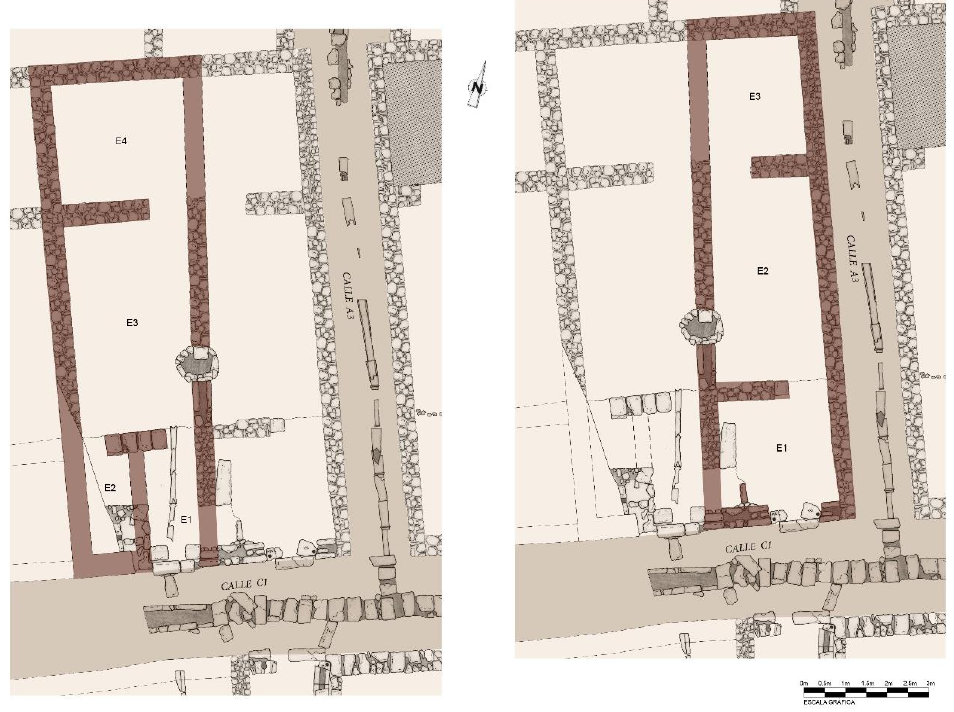
Figure 28. House 24b and House 24a. Plan and room distribution (Aparicio Sánchez 2021, Figure 2A).